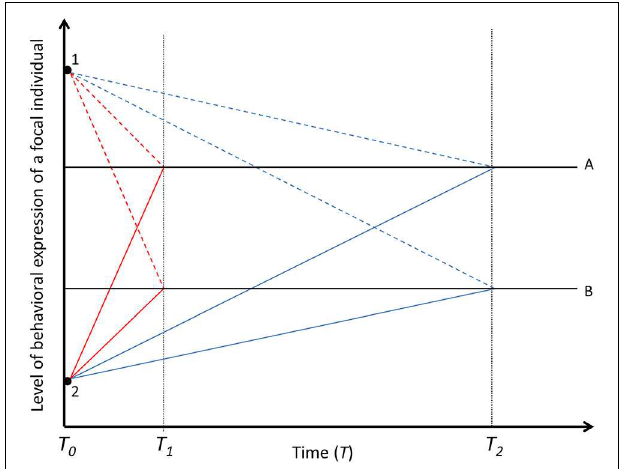
FIGURE 4 | Decay of the among-individual variation in time. Solid black lines (A and B) represent two focal individuals with different mean baseline levels of behavioral expression. Colored lines represent the behavioral expression of two focal individuals (A and B) under the influence of social carry-over effects [Black dots; dashed lines for the effect of partner 1 and solid lines for the effect of partner 2, underpinned by fast-changing (red lines, decayed in T 1 ) or slow-changing (blue lines, decayed in T 2 ) states in focal individuals]. If social carry-over effects are underpinned by fast-changing states, the social environment (1 and 2) explains among-individual variation in the behavior of the focal individuals only over short temporal scales. If social carry-over effects are underpinned by slow-changing states, the social partners explain among-individual variation in the behaviors of the focal individuals over long temporal scales. Black dashed lines for focal individuals A and B represent the permanent social carry-over effects, i.e., true animal personality created by social environment. The social interaction is terminated in T 0 . For simplicity, the partner effects are assumed to be the same magnitude in T 0 for the fast- and slow-changing